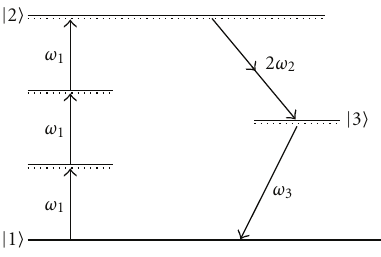
Figure 1: Six-wave interaction